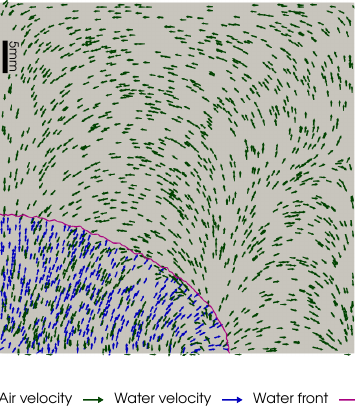
Figure 13. Model CUBE: Phase velocities after 5 min (0.16 PV).